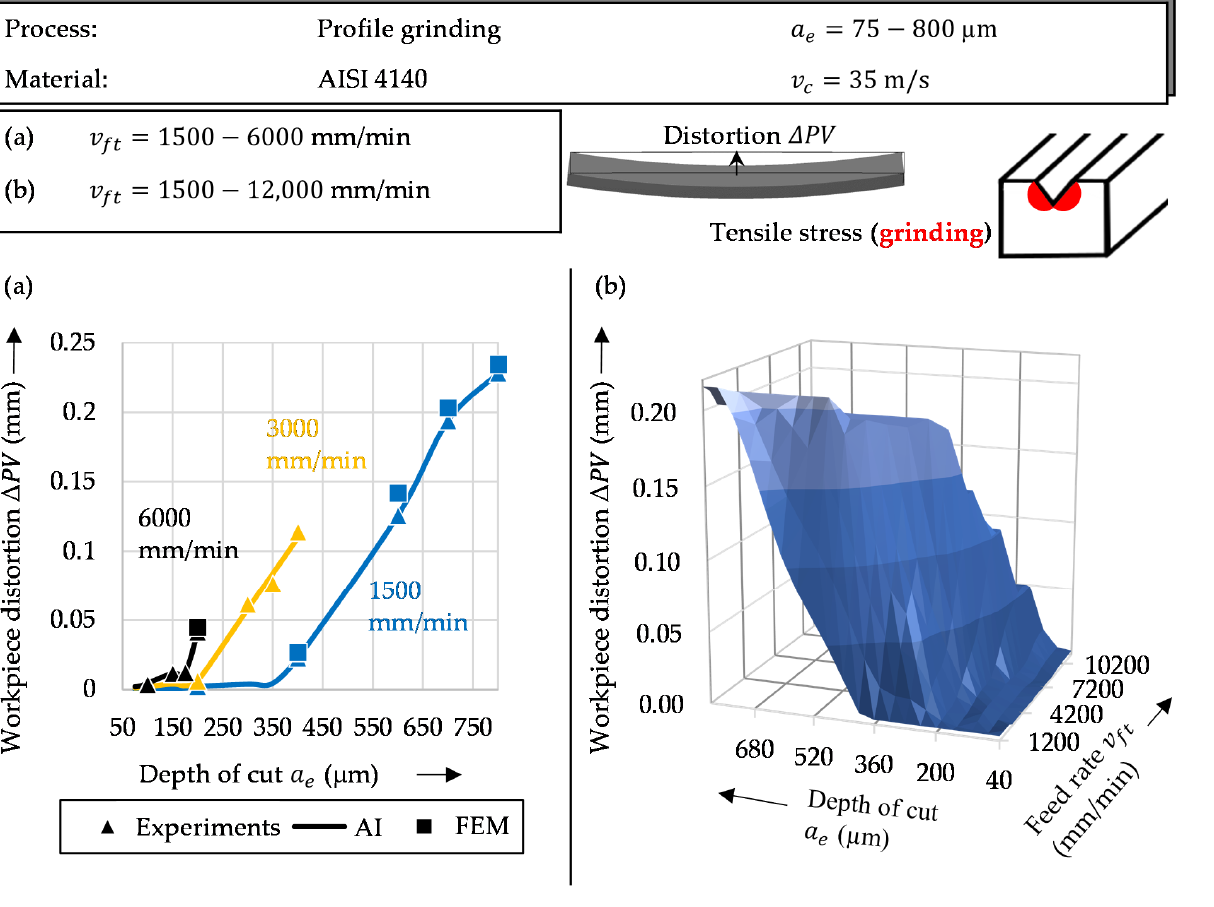
Figure 4. The workpiece distortion Δ PV (peak-to-valley) values after the profile-grinding process for different depths of cut and tangential feed rates: ( a ) examples for experimental and numerical results (FEM) and ( b ) distortions predicted by the AI regression model .